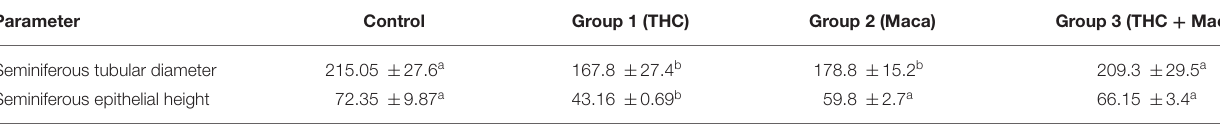
TABLE 1 | Morphometry of the testis of control and experimental group 1 (THC), group 2 (Maca), and group 3 (THC + Maca).